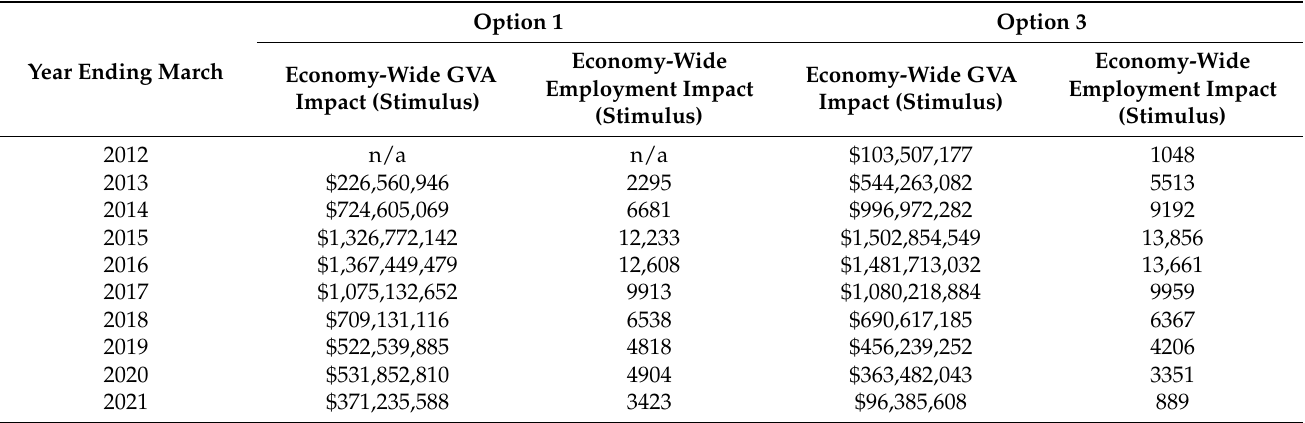
Table 2. Input–Output results of stimulus injection, 2012–2021.